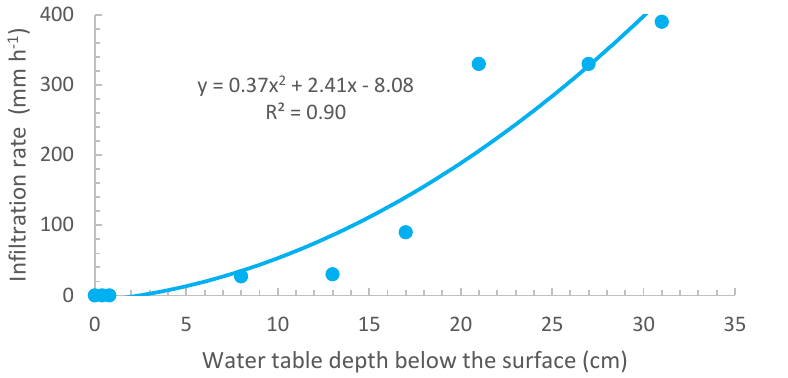
Figure 7. Infiltration rate vs. groundwater table depth in the Debre Mawi watershed. Groundwater table depth values taken on the same date with infiltration rate are plotted.